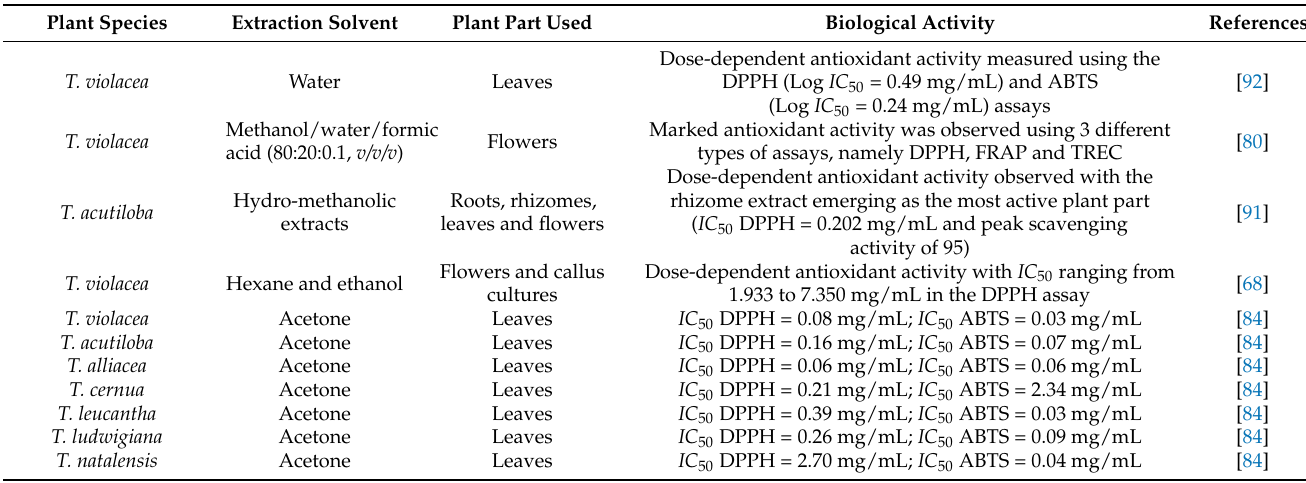
Table 6. Antioxidant activity of Tulbaghia species.